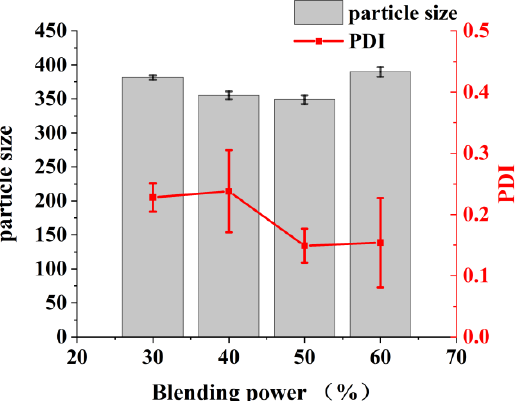
Figure 1. Hydrodynamic particle sizes and polydispersity indices (PDIs) determined by dynamic laser scattering after different emulsification powers had been used.